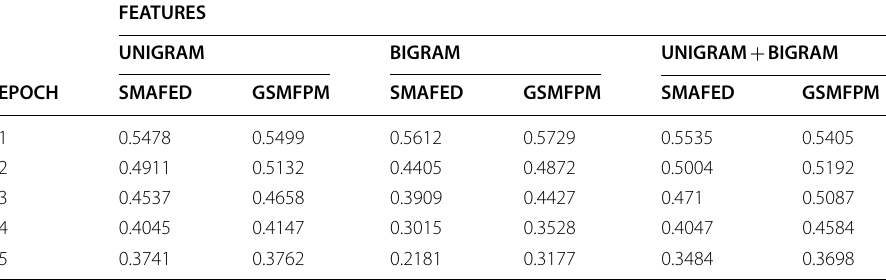
Table 11 Multi-layer perceptron cross-entropy loss function for GSMFPM and SMAFED on twitter sentiment analysis training corpus